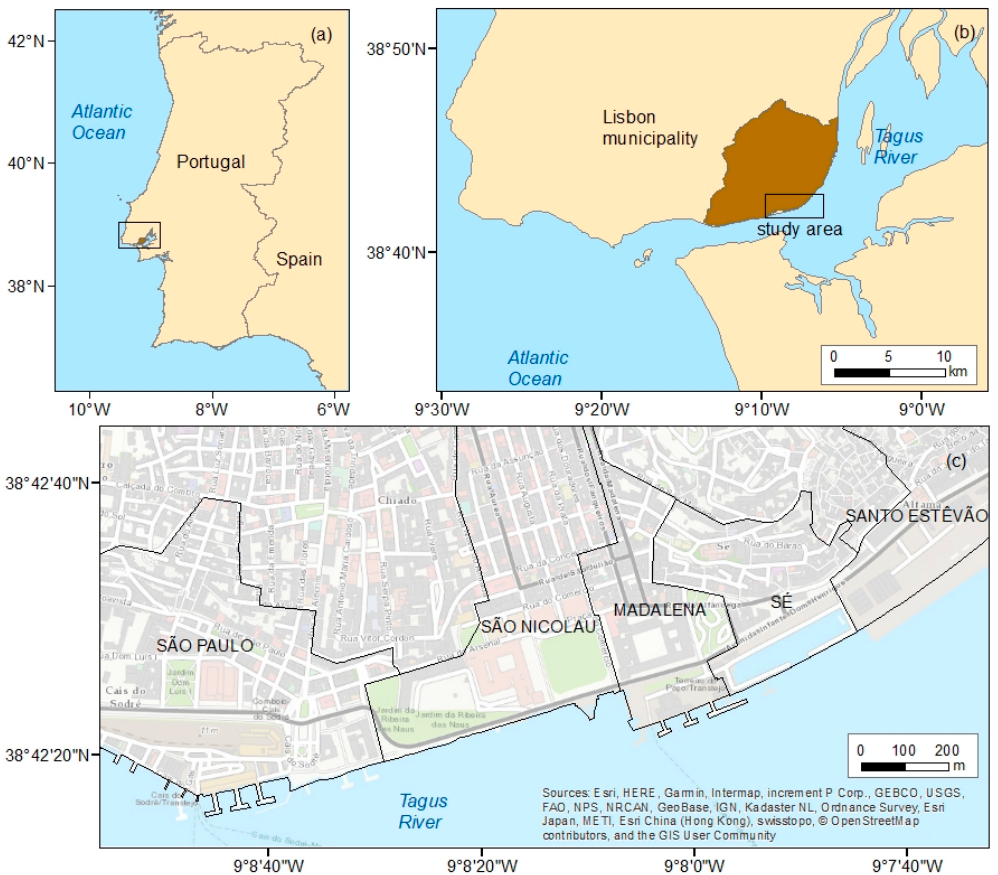
Figure 1. Geographical setting of the study area: ( a ) Location of Portugal and the Lisbon municipality; ( b ) location of the study area; ( c ) details of the study area, which in 2010 had 5 civil parishes.